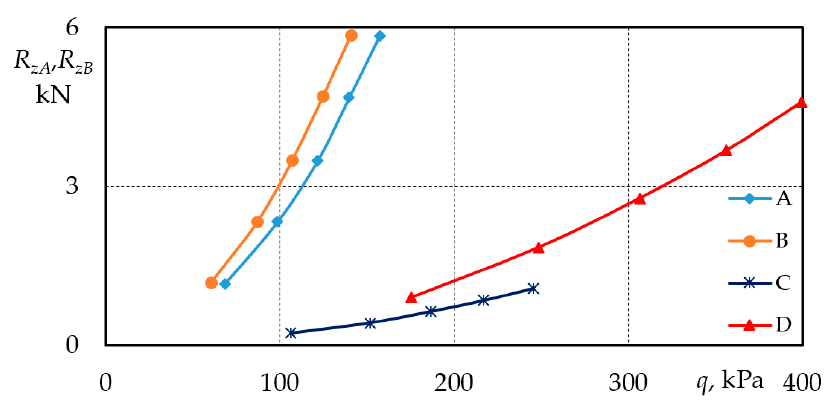
Figure 8. Radial loads of the tires (marking according to Table 2).